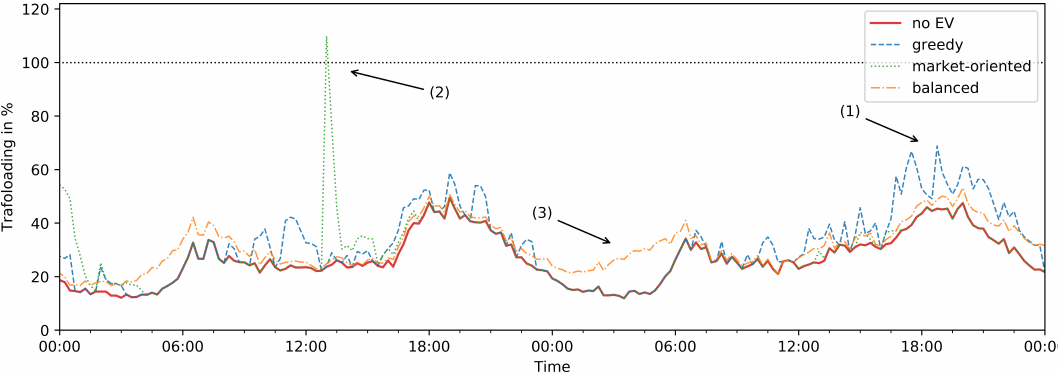
Figure 7. Load profile for each charging strategy in Berlin for 2 days in the private space. Figure 8 depicts the impact of the three different charging strategies on rural and urban grids. The region types “rural” and “urban” each contain three grids’ power flow calculation results. The results show that grid components such as transformers and lines in rural grids are exposed to much higher stress than urban grid components. This stress in rural grids is due to the higher number of BEVs with home charging point in 2040 (rural 54%, urban 18%). Furthermore, within the examined urban grids, transformers and lines can carry a higher power related to the household number within the grid. Longer line length and the resulting voltage drop over these lines additionally cause higher voltage deviation in the rural grids.